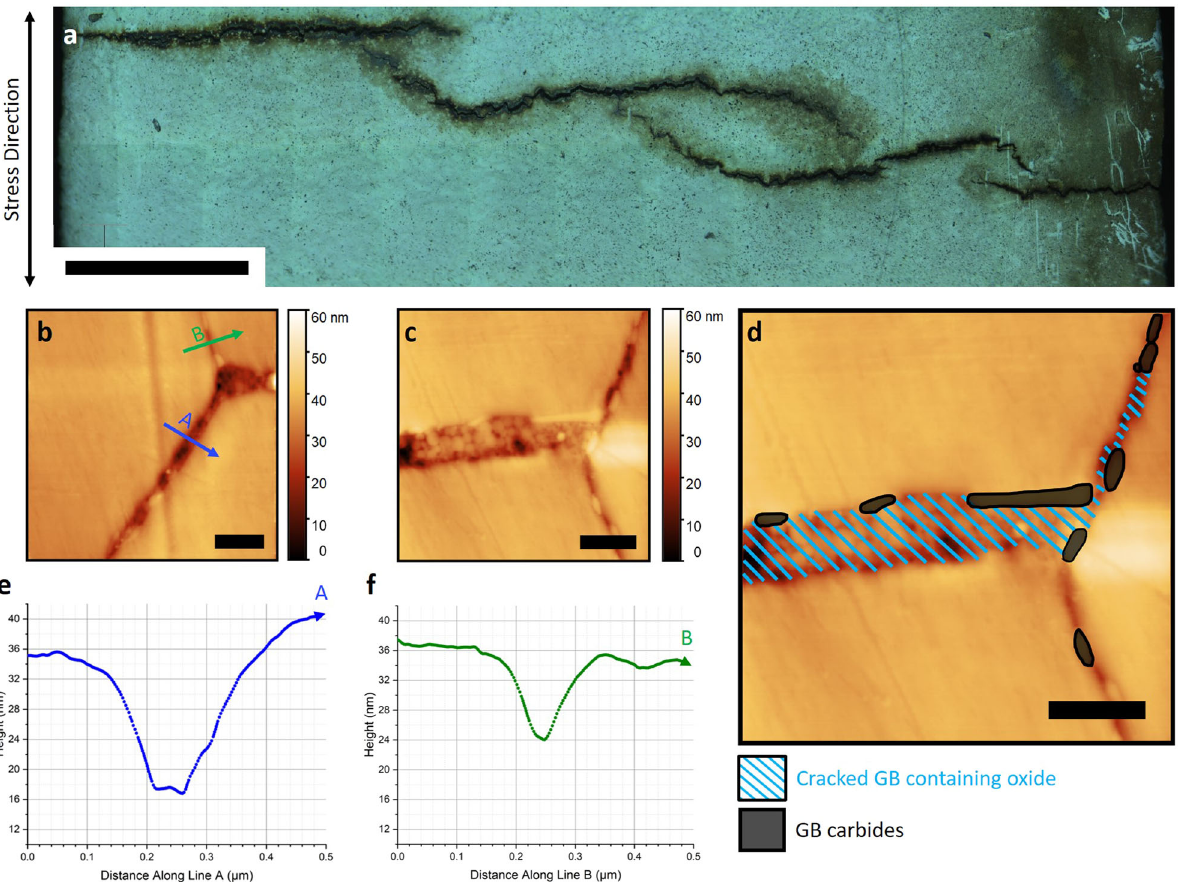
Fig. 4 Ex situ optical and HS-AFM measurements of IGSCC. a An optical image across the whole width of the sample after failure by IGSCC, (scale bar: 500 µm). ( b ) and ( c ) are images showing HS-AFM topographic maps of a microcrack measured in a different polished cracked sample, with height colour map, imaged within deionised water (scale bars: 500 nm). A labelled version of the image shown in ( c ) is given in ( d ). Also shown are line pro fi les collected for: e the line labelled A shown in ( b ) as a dark blue line, f the line labelled B shown in ( b ) as a green line, showing the difference between cracked GBs and non-cracked GBs. Height measurements have an error of ±15